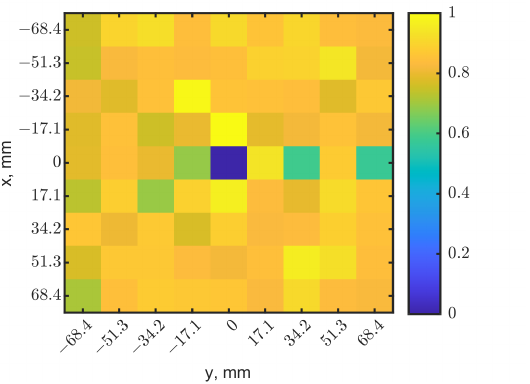
Figure 9. Synthesized heatmap with a weight W = 0.5 in the normalized resonant frequencies and |s 11 |. The dark-blue pixel indicates the tumor’s location.